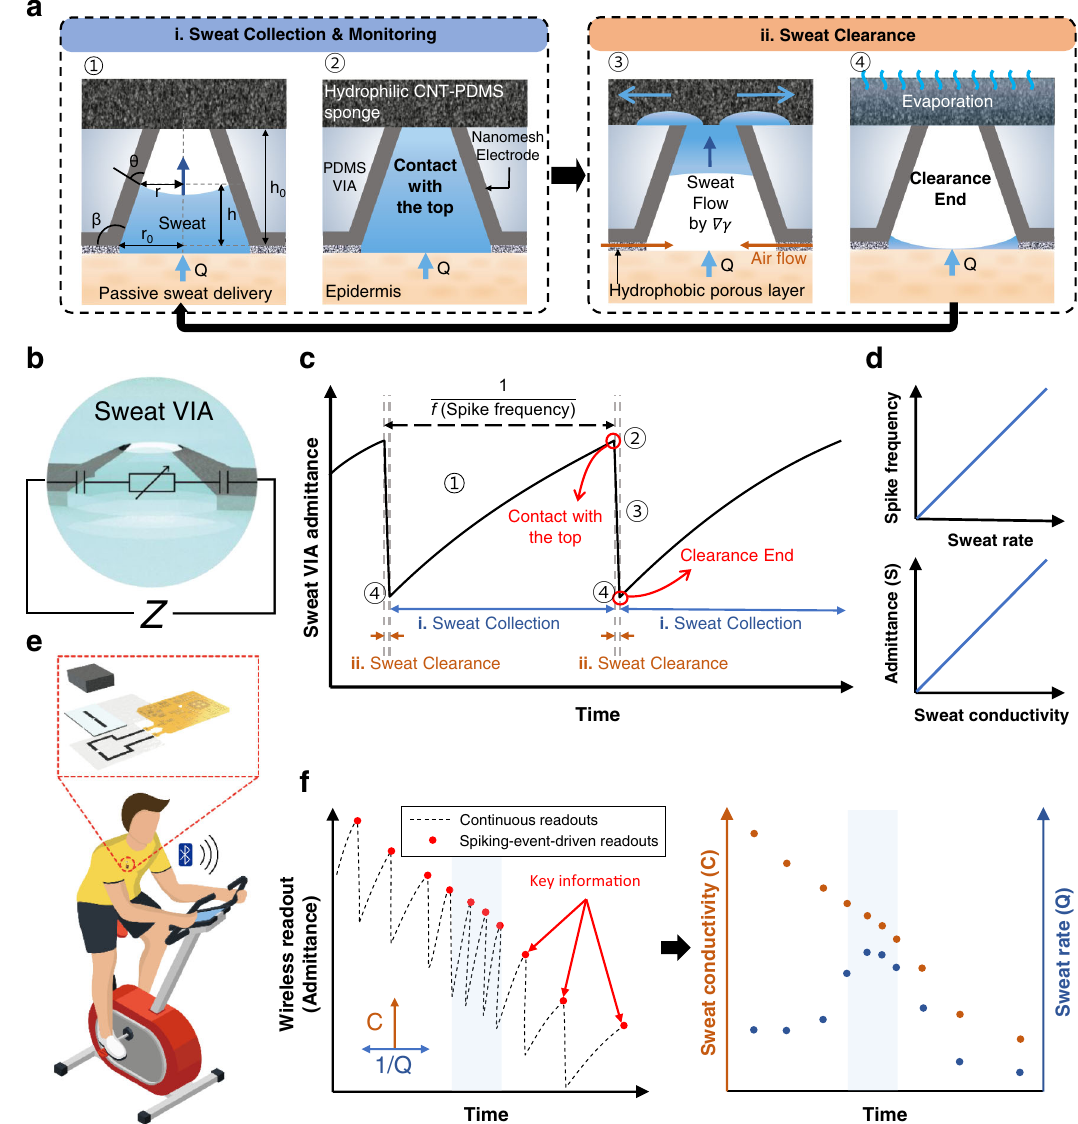
Fig. 2 | Structures and operating principles of the sweat VIA sensor and event- driven wireless monitoring of epidermal perspiration. Schematic diagrams of a the structures and operating principles of the sweat VIA sensor and b its equivalent circuit. c Example of a spike admittance curve produced by the sweat VIA sensor during the collection and clearance of sweat. d Schematic of the sweat rate versus spike frequency and sweat conductivity versus peak admittance of the